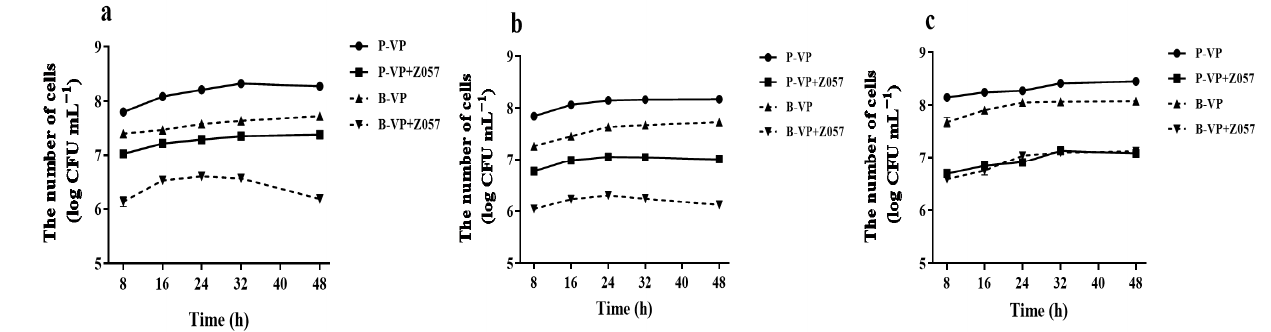
Figure 1. Competition ( a ), exclusion ( b ), and displacement ( c ) ability of L. plantarum Z057 against V.